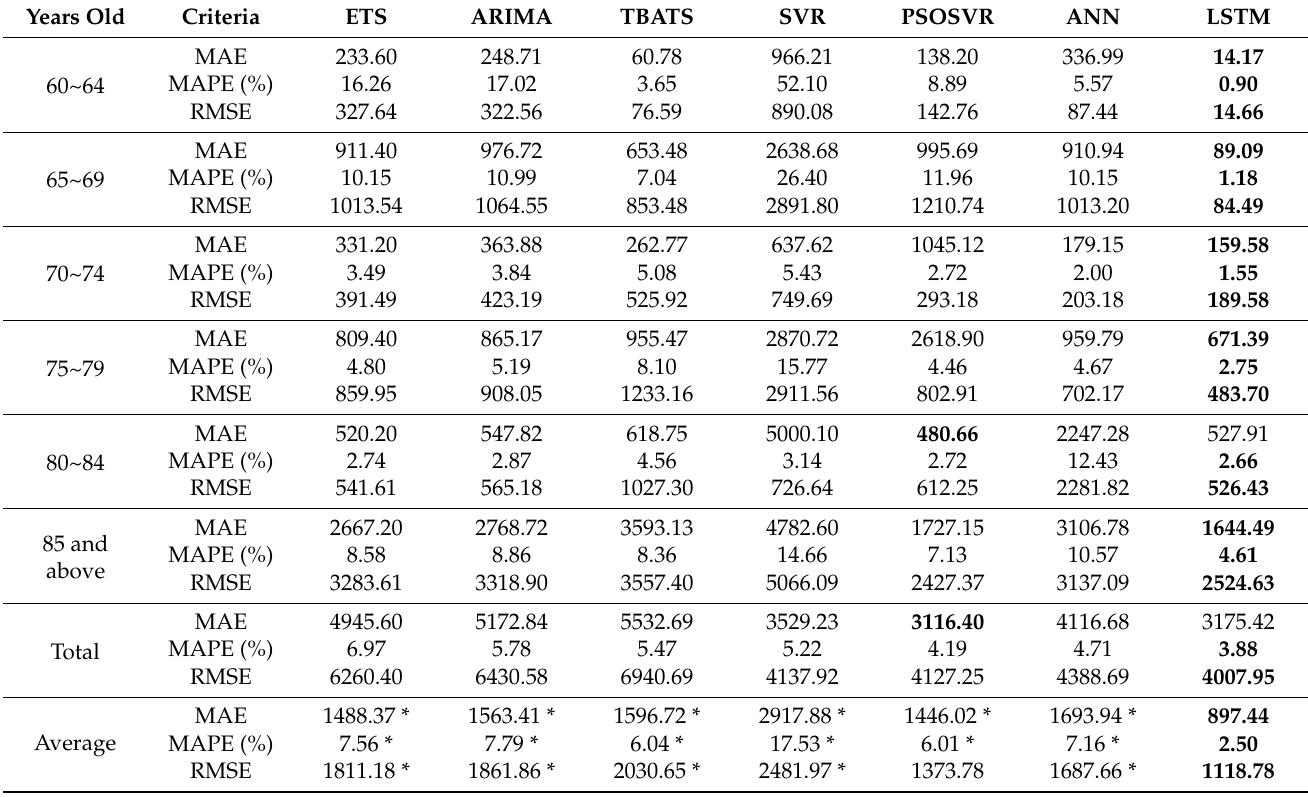
Table 4. Predicted results for male dementia patients using different